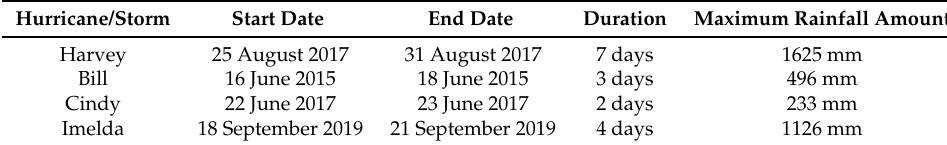
Figure 1. Accumulative rainfall for four events combined is measured by Multi-Radar Multi-Sensor (MRMS) radar data. Four cyclone tracks are illustrated with lines. Red dots (numbers from 1 to 4) in the bottom right panel are selected representative pixels in the Harvey core region. Table 1. Events